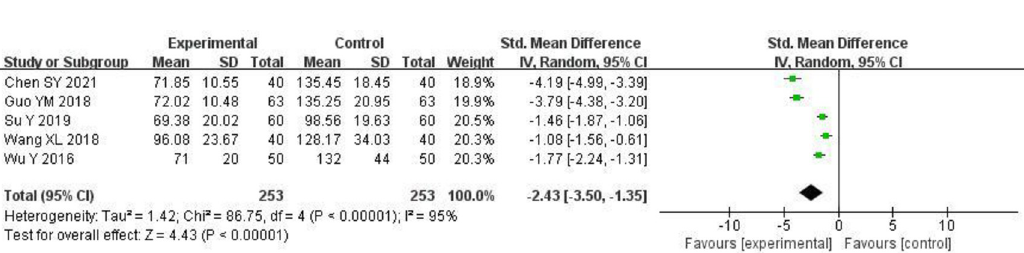
Fig 7. Forest plot of effects of Shenyankangfu tablets and Losartan potassium in the treatment of chronic glomerulonephritis on urine NAG enzyme.